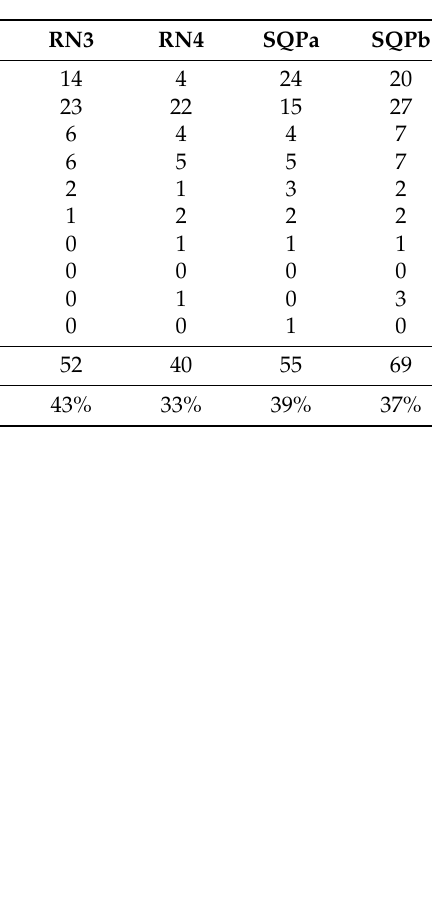
Table 4. Number of SD species among the studied forest sites (NNP, Podlaskie, North-East Poland)